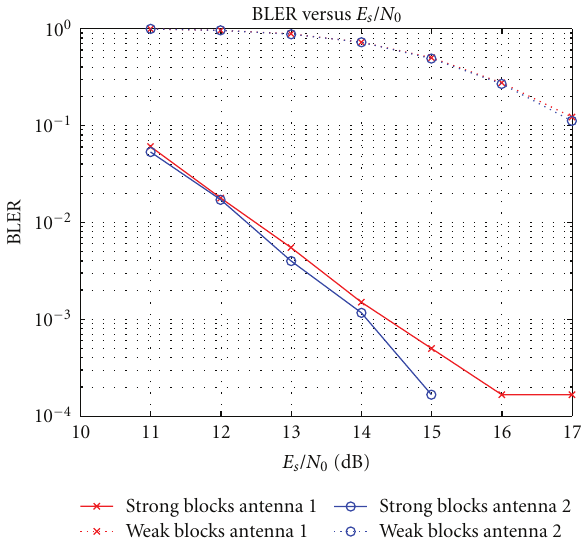
Figure 9: BLER performance of 2 × 2 MIMO 16QAM turbo-coded transmission without RM, TypU channel.